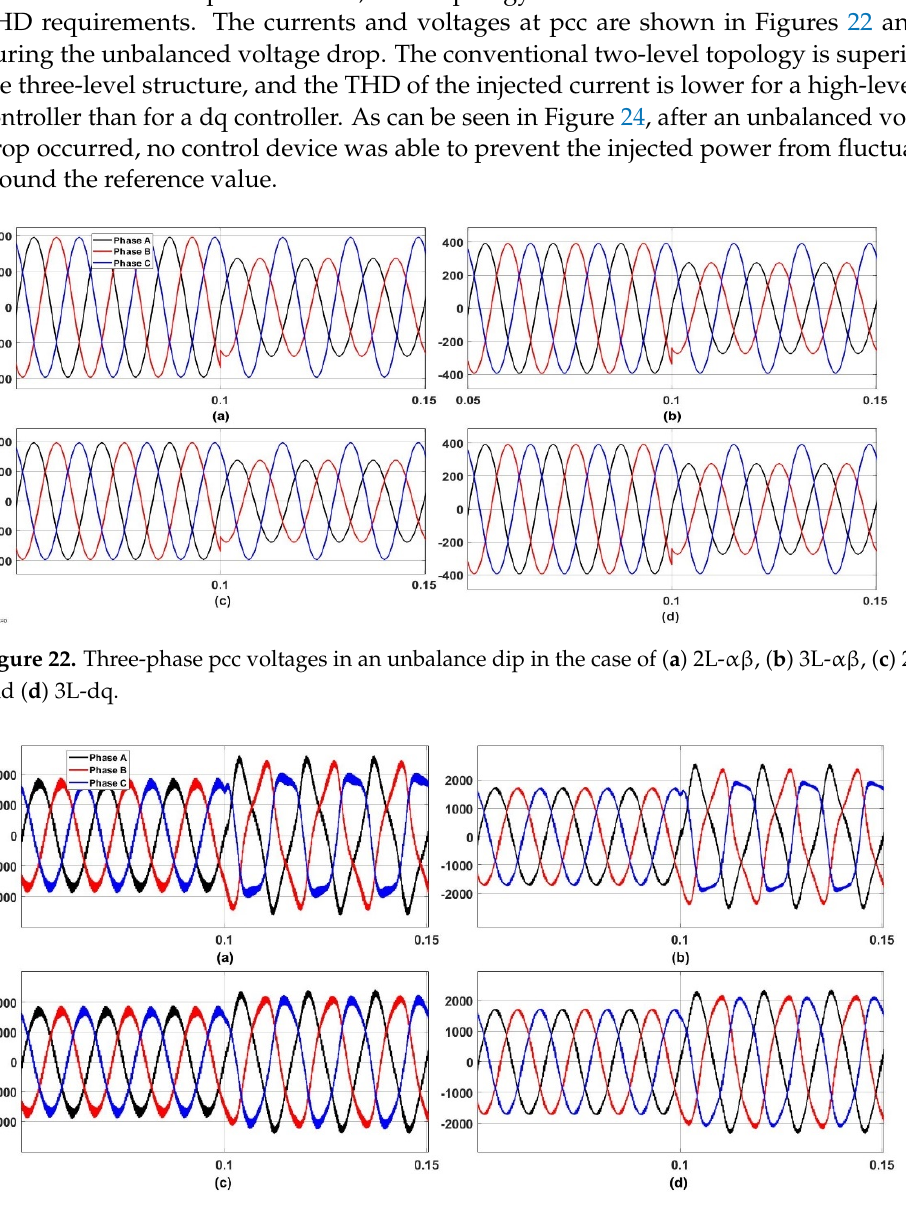
Figure 24. Power flow in an unbalance voltage dip in the case of ( a ) 2L- αβ , ( b ) 3L- αβ , ( c ) 2L-dq and ( d ) 3L-dq . Figures 25 and 26 show the pcc voltages and currents during an unbalanced voltage swell. While the dq controller still has a lower THD in the injected current than the high- level αβ controller, the performance of the three-level structure is superior to that of the two-level structure. Moreover, as can be seen in Figure 27, after an unbalanced voltage